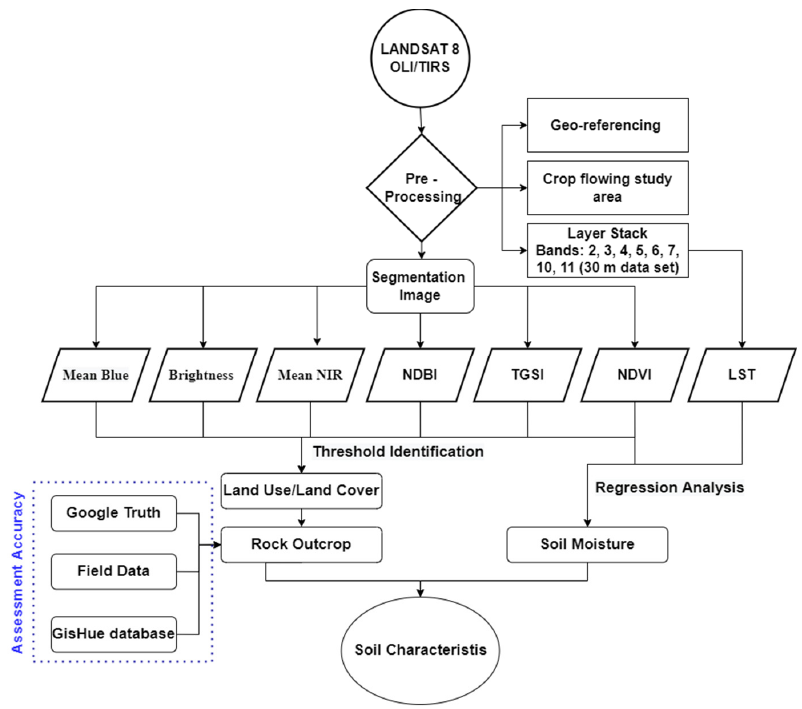
Figure 2. Flowchart of the research.